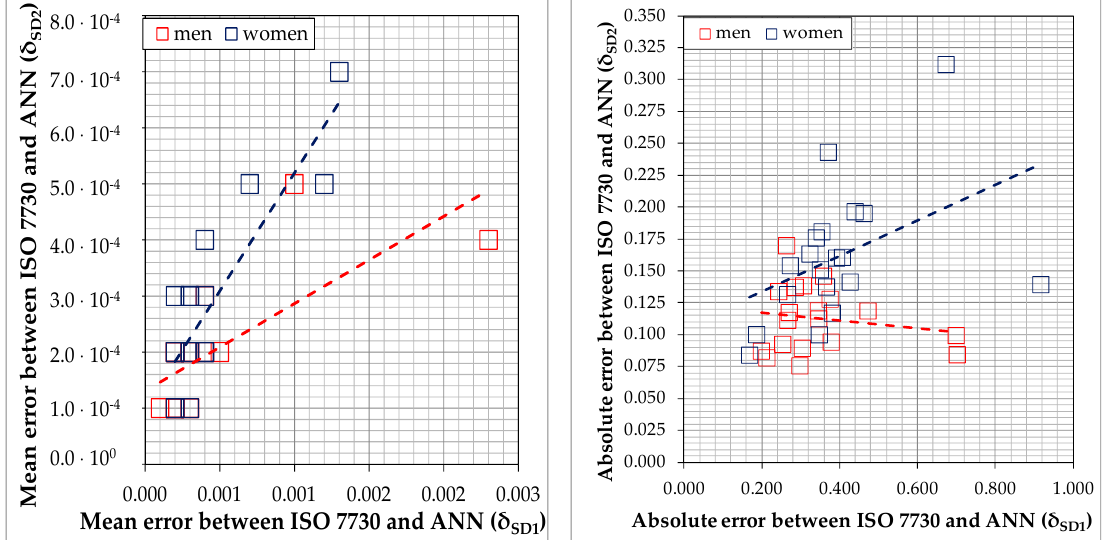
Figure 10. Mean relative and mean absolute errors between PMV standard and PMV ANNcomfort for men and women configurations: comparison considering δ SD1 and δ SD2 ranges.